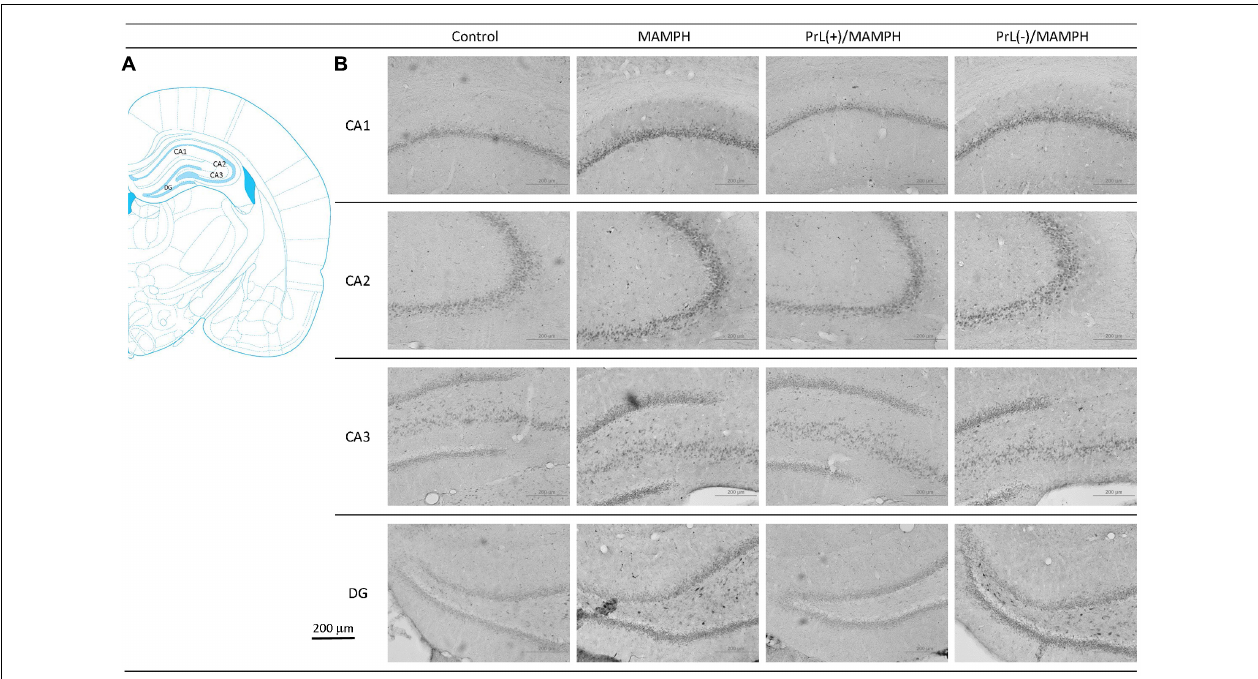
FIGURE 14 | (A) A schematic brain atlas for the CA1, CA2, CA3, and DG of the hippocampus. (B) Representative photomicrographs of p-ERK expression for the CA1, CA2, CA3, and DG of the hippocampus in the control, MAMPH, PrL(+)/MAMPH, and PrL(–)/MAMPH groups. The scale bar represents 200 µ m.